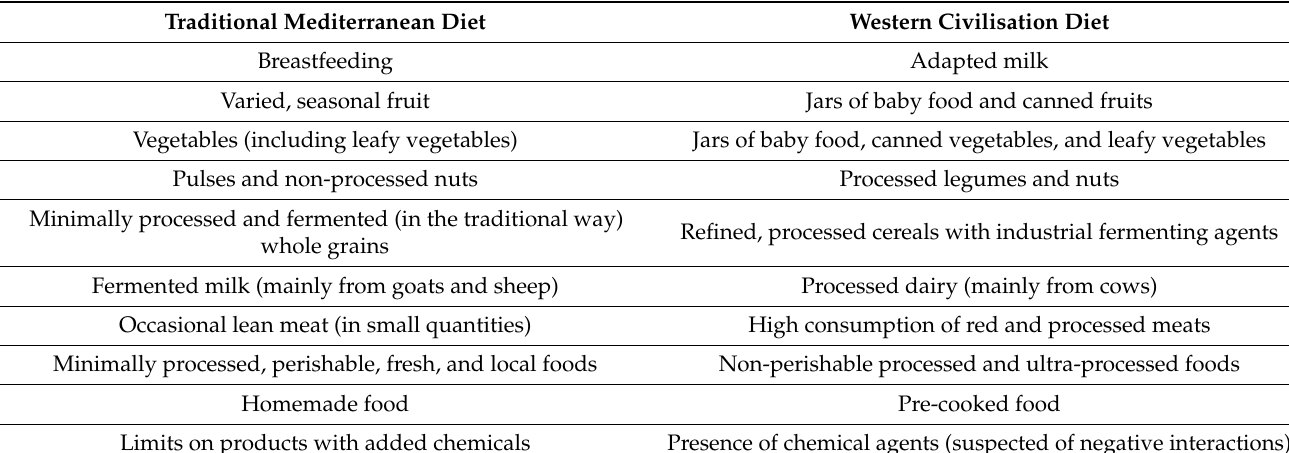
Table 1. Differences between the Traditional Mediterranean Diet and the ‘Western Civilisation’